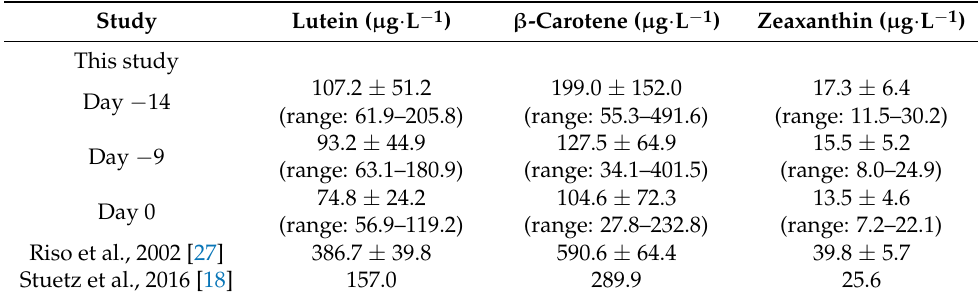
Table 1. Plasma carotenoid concentrations of volunteers at the time of recruitment with additional data from literature. Values represent means ± SD.